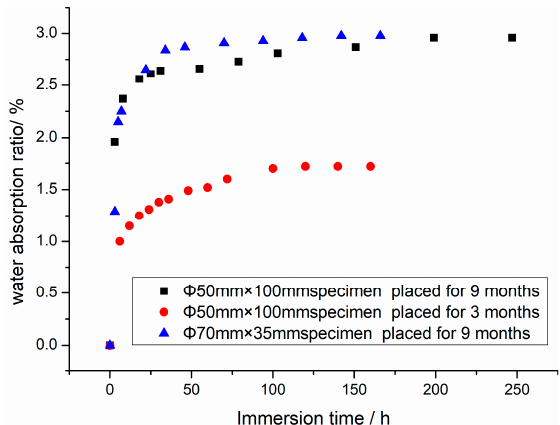
Figure 2. Variation of water absorption ratio with immersion time for specimens placed in a dry room for different times after immersion.